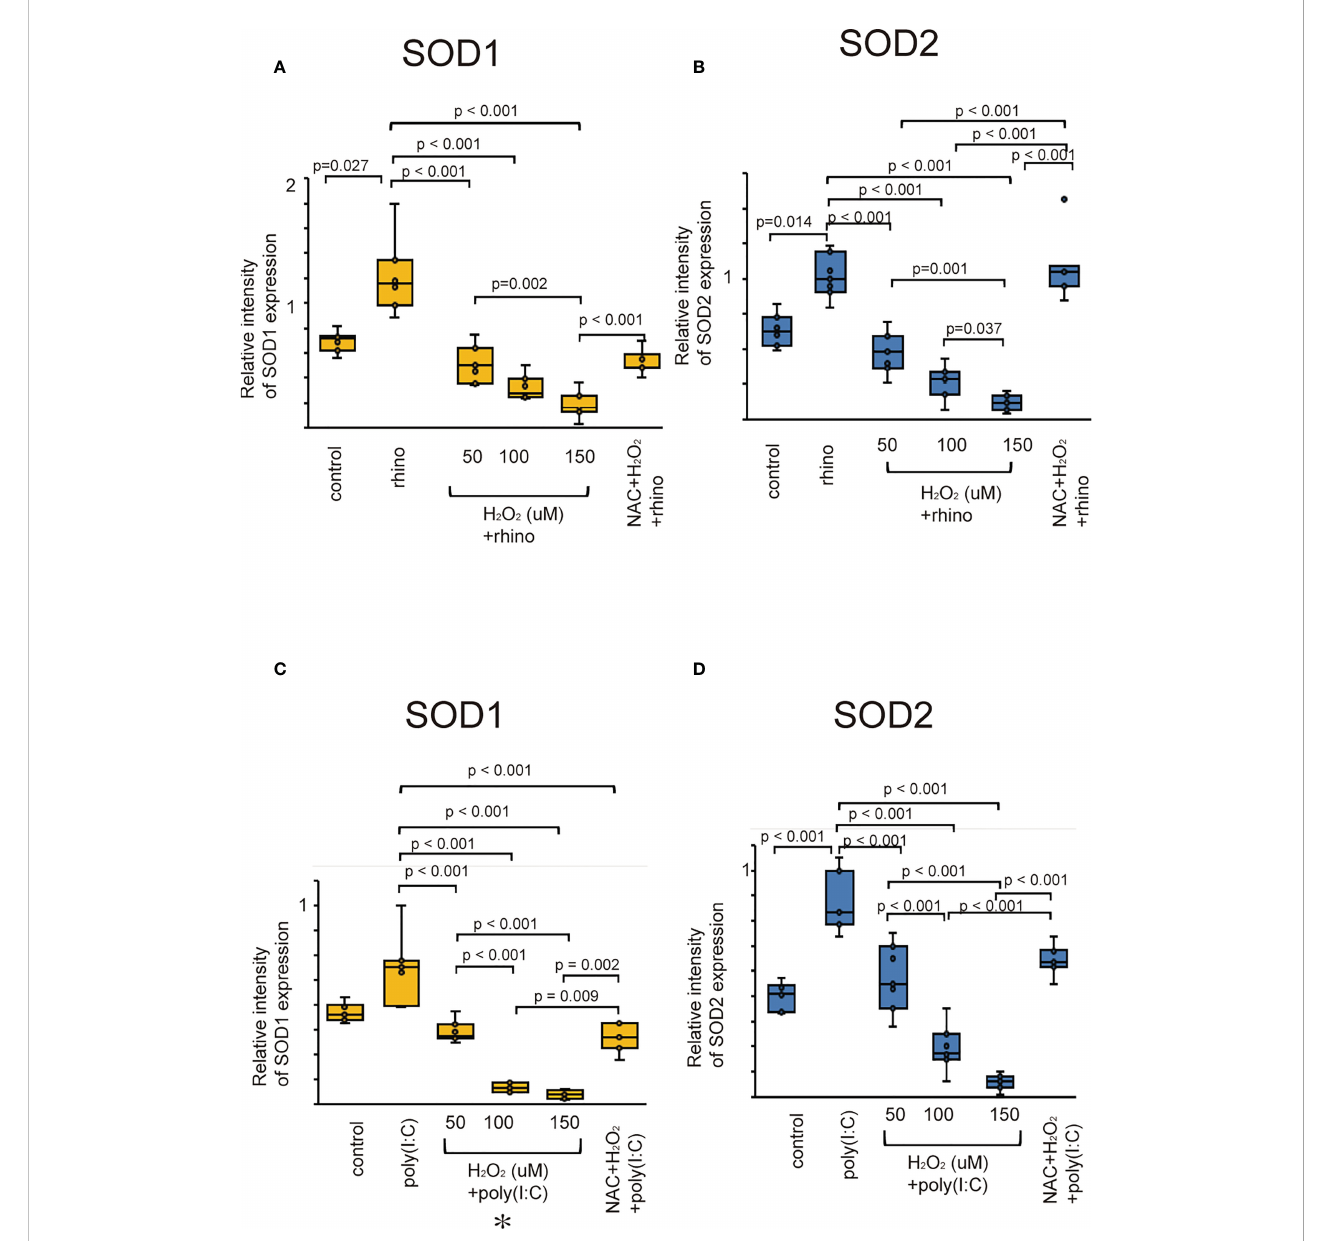
FIGURE 2 The expression levels of SOD1 (A, C) and SOD2 ( B, D) in cultured sinonasal epithelial cells pretreated with H 2 O 2 at 50, 100, and 150 uM and then followed by RV 16 infection (A, B) and poly (I:C) treatment (C, D) , which were evaluated by western blot. Data are mean ± SEM from 7 different epithelial donors. Control indicates non-treated normal epithelial cells. Rhino indicates epithelial cells infected with RV 16. H 2 O 2 +rhino indicates the epithelial cells pretreated with H 2 O 2 at 50, 100, and 150 uM followed by RV 16 infection. NAC+ H 2 O 2 +rhino indicates the cells which were pretreated with NAC at 5 mM for 1 h and then followed by H 2 O 2 treatment at 100 uM and subsequently infected with RV 16. Poly (I:C) indicates epithelial cells treated with poly (I:C). H 2 O 2 +poly (I:C) indicates the epithelial cells pretreated with H 2 O 2 at 50, 100, and 150 uM followed by poly (I:C) treatment. NAC+ H 2 O 2 +poly (I:C) indicates the cells which were pretreated with NAC at 5 mM for 1 h and then followed by H 2 O 2 treatment at 100 uM and subsequently treated with poly (I:C). Rhino indicates RV 16. NAC indicates